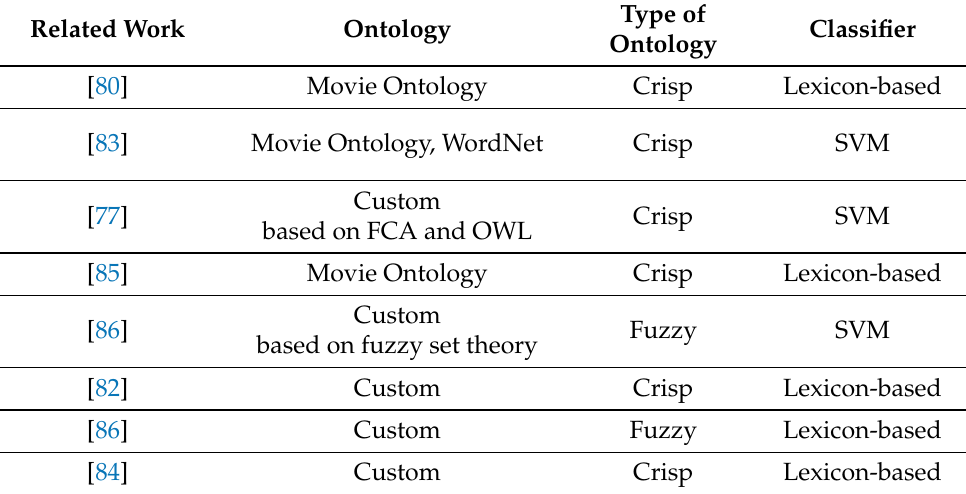
Table 2. Related works organized according to specific